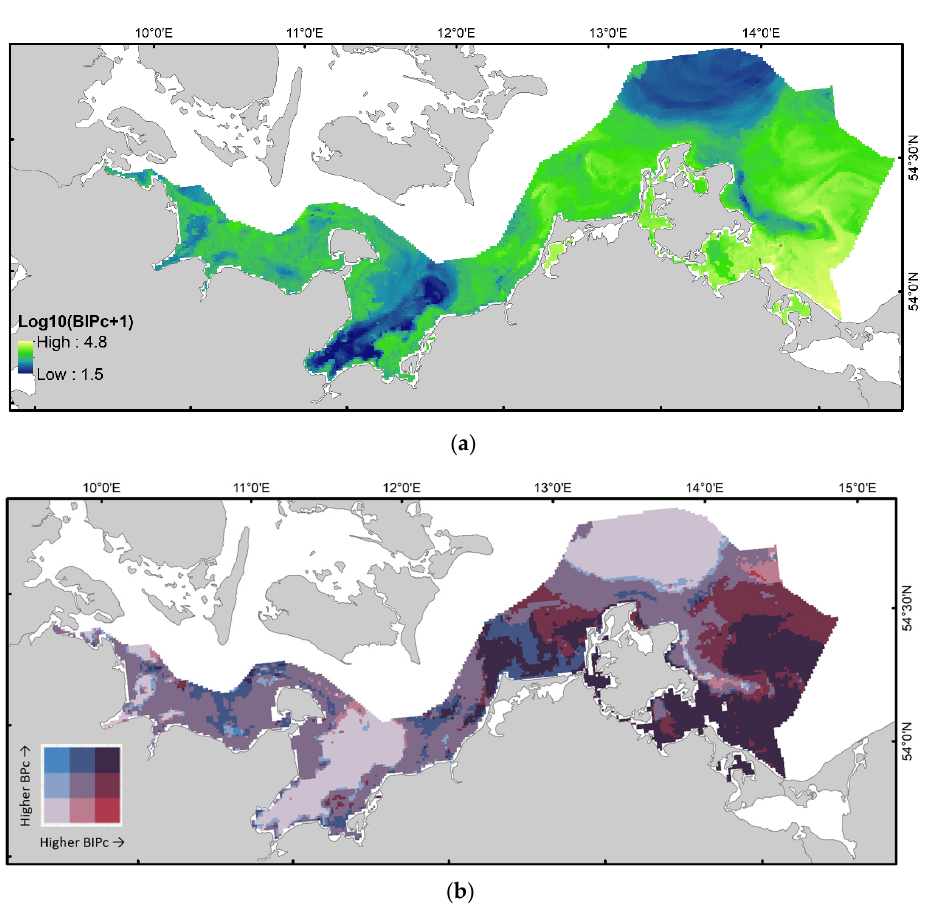
Figure 4. Predicted spatial distribution of BIPc (log-transformed) in the south-western Baltic Sea ( a ). Bivariate map of bioturbation and bioirrigation potentials hotspots in the south-western Baltic Sea ( b ). The distribution of BPc is a modelling result obtained using the same method and reported in Gogina et al. [20]. Red areas indicate relatively higher scores of BIPc compared to BPc, whereas blue areas are solely hotspots of BPc, but not of BIPc.